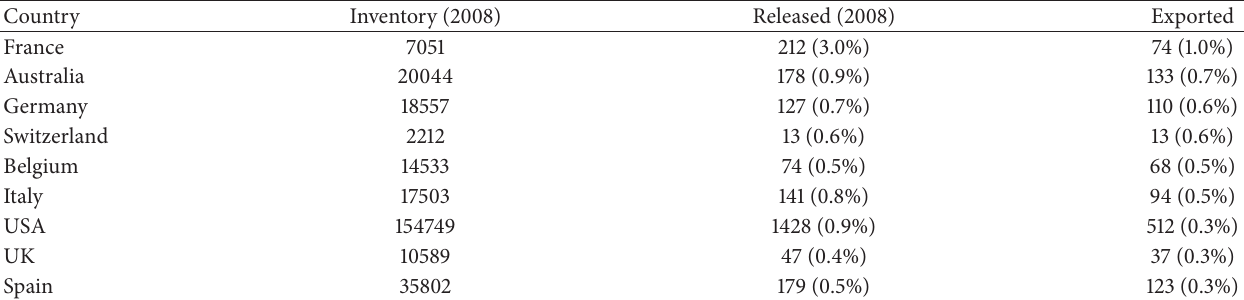
Table 1: Analysis of cord blood units released and exported from cord blood banks around the